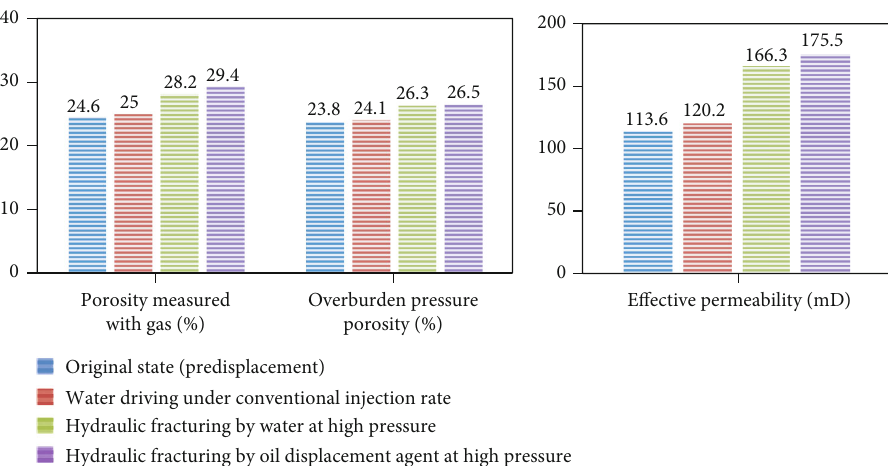
Figure 7: Results of porosity and permeability measurements of core 21-2.